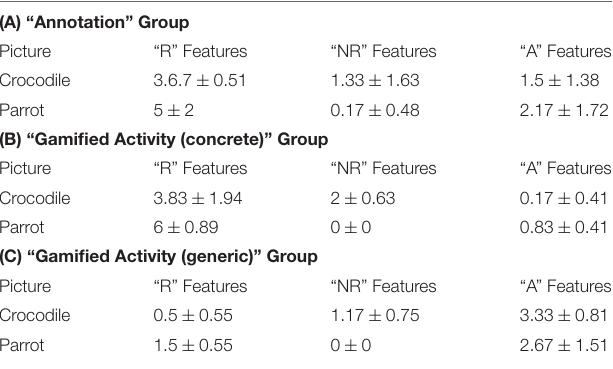
TABLE 1 | The table represents the average and the sample m.s.e. per participant for each feature type and for each